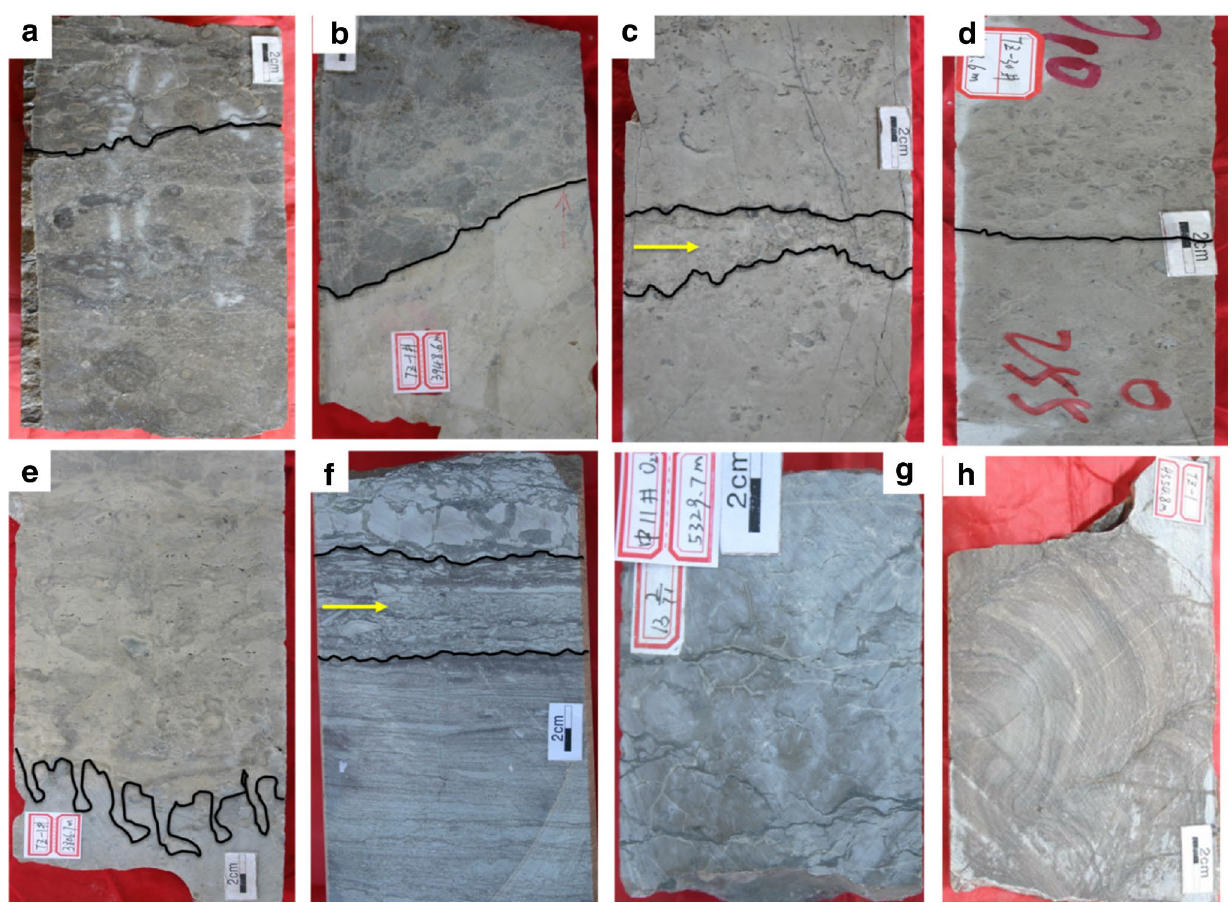
Fig. 4 Core photographs of the reef and shoal facies showing: a bio- clastic oncoidal packstone (MF-1), overlying lower intraclastic ooidal grainstone and are separated by low-amplitude stylolite; b bioclas- tic peloidal grainstone (MF-14) lying unconformably on bioclastic paloidal wackestone bed (MF-13); c upper lime mudstone–wacke- stone bed (MF-7), truncated by bioclastic ooidal–peloidal grainstone (MF-10), separated by erosional surfaces; d intraclasts, bioclastic peloidal packstone (MF-9), overlying peloidal wackestone bed (MF- 12), truncated by an erosional surface; e bioturbated peloidal wack-